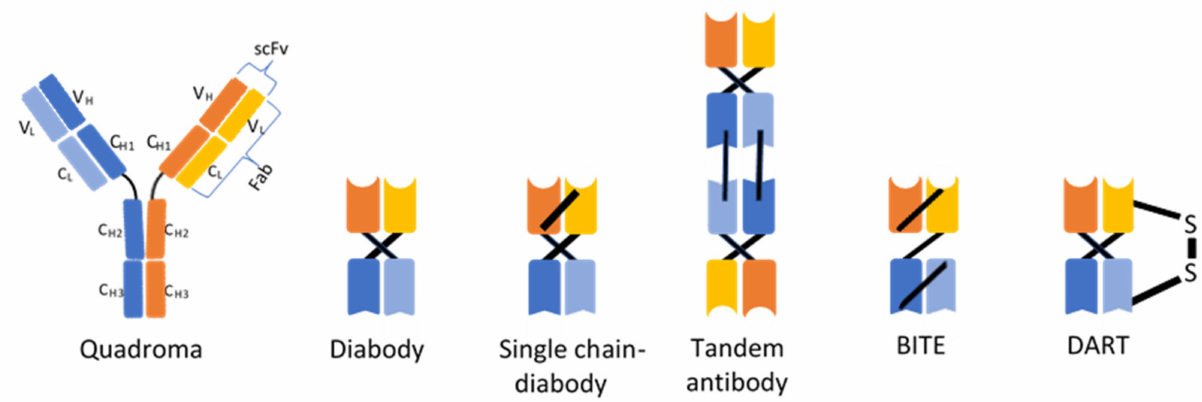
Figure 1. Selected recombinant antibodies developed for anti-cancer therapies. BITE—bispecific T-cell engager, DART—Dual affinity